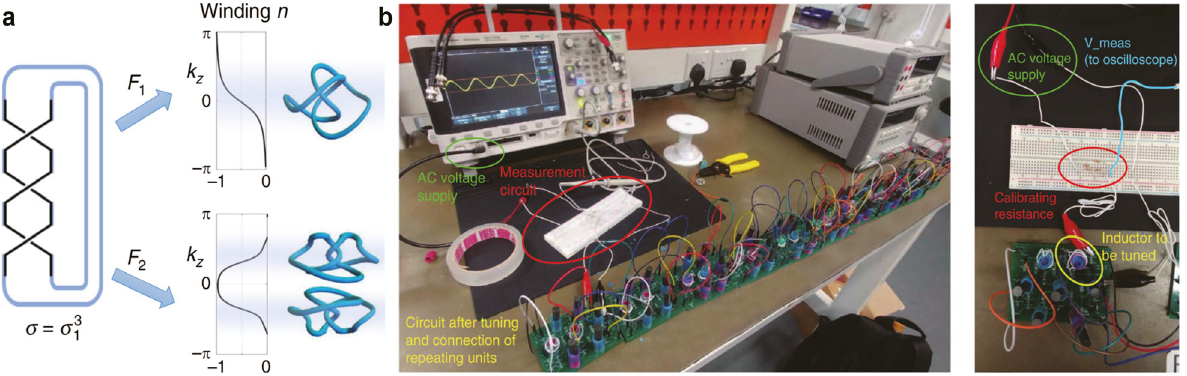
Figure 10: Nodal knot and link using electrical circuits. (a) Mathematical models construct a nodal knot/link from a braid. A braid closure can be embedded onto the three-dimensional Brillouin zone torus differently through different choices of F ( k ) functions. Depending on its topological charge density distribution, it produces different numbers of nodal knots in the Brillouin zone, i.e. either a single copy ( F Experimental setup for impedance measurement of the Hopf-link circuit. Reproduced with permission from Reference [27]. Copyright 2020, Nature Portfolio (a) and (b).